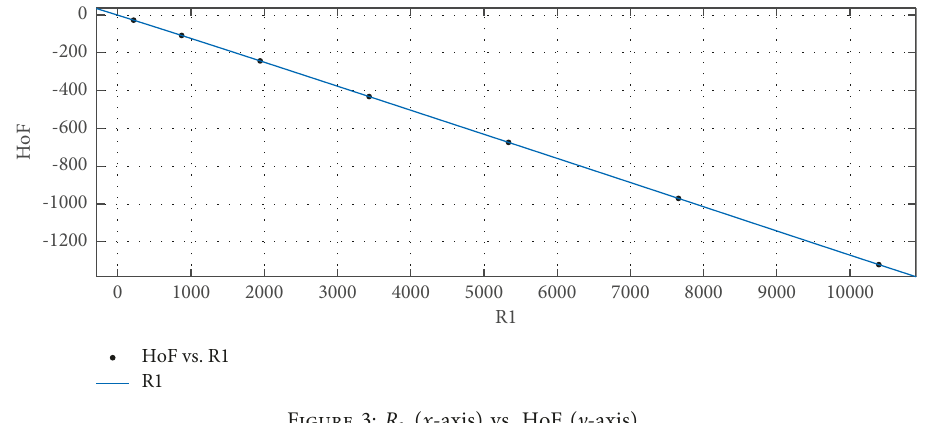
Figure 3: R ( x -axis) vs. HoF ( y -axis). 1